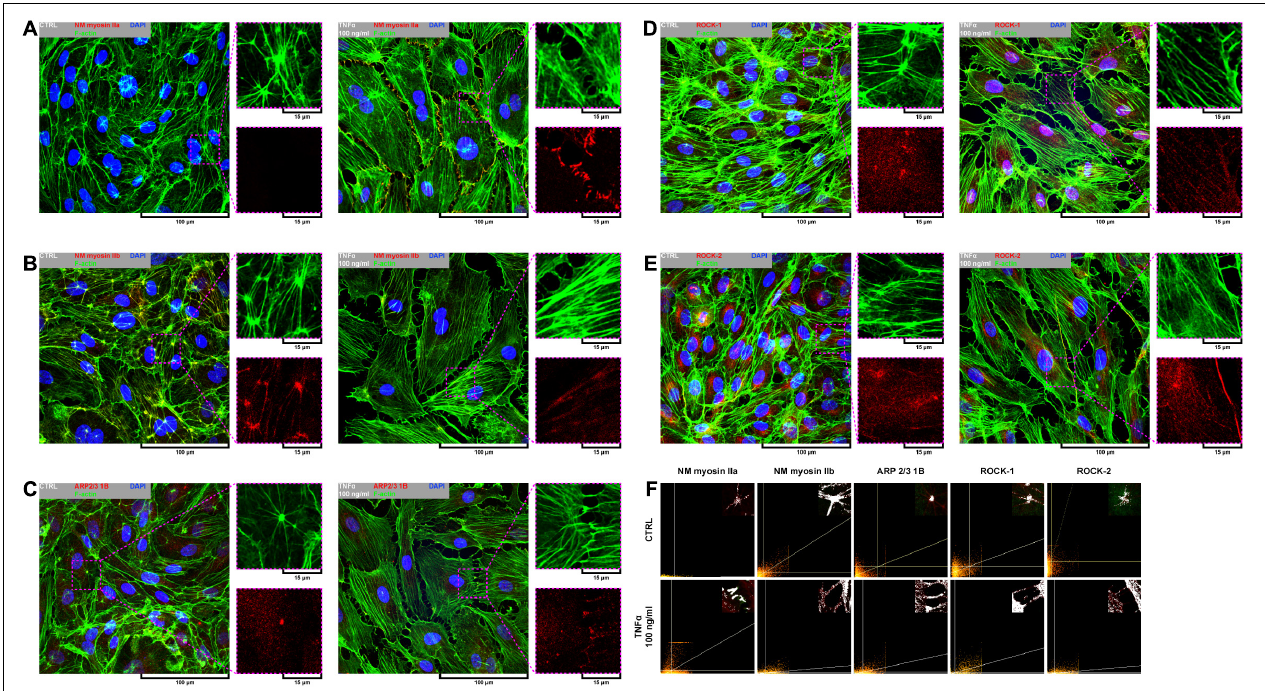
FIGURE 4 | Effect of TNF α on organizational pattern of F-actin and distribution of proteins regulating actin assembly and mechanics in pHCAECs. (A) Representative confocal micrograph of fluorescently stained F-actin and NM myosin IIa. Triple fluorescent staining for NM myosin IIa (red), F-actin (green), and DNA (blue) was performed after fixation. CTRL refers to the control (left panel), TNF α 100 ng/ml to cells treated with rh TNF α (right panel), NM to non-muscle. (B) Representative confocal micrograph of fluorescently stained F-actin and NM myosin IIb. Triple fluorescent staining for NM myosin IIb (red), F-actin (green), and DNA (blue) was performed after fixation. CTRL refers to the control (left panel), TNF α 100 ng/ml to cells treated with rh TNF α (right panel), NM to non-muscle. (C) Representative confocal micrograph of fluorescently stained F-actin and ARP2/3. Triple fluorescent staining for subunit 1B of ARP2/3 (red), F-actin (green), and DNA (blue) was performed after fixation. CTRL refers to the control (left panel), TNF α 100 ng/ml to cells treated with rh TNF α (right panel). (D) Representative confocal micrograph of fluorescently stained F-actin and ROCK-1. Triple fluorescent staining for ROCK-1 (red), F-actin (green), and DNA (blue) was performed after fixation. CTRL refers to the control (left panel), TNF α 100 ng/ml to cells treated with rh TNF α (right panel). (E) Representative confocal micrograph of fluorescently stained F-actin and ROCK-2. Triple fluorescent staining for ROCK-2 (red), F-actin (green), and DNA (blue) was performed after fixation. CTRL refers to the control (left panel), TNF α 100 ng/ml to cells treated with rh TNF α (right panel). (F) Representative co-localization maps of NM myosin IIa, NM myosin IIb, subunit 1B of ARP2/3, ROCK-1, and ROCK-2 with star-like-shaped F-actin (upper panels) or F-actin of cell–cell interactions (lower panels). CTRL refers to the control (upper panels), TNF α 100 ng/ml to cells treated with rh TNF α (lower